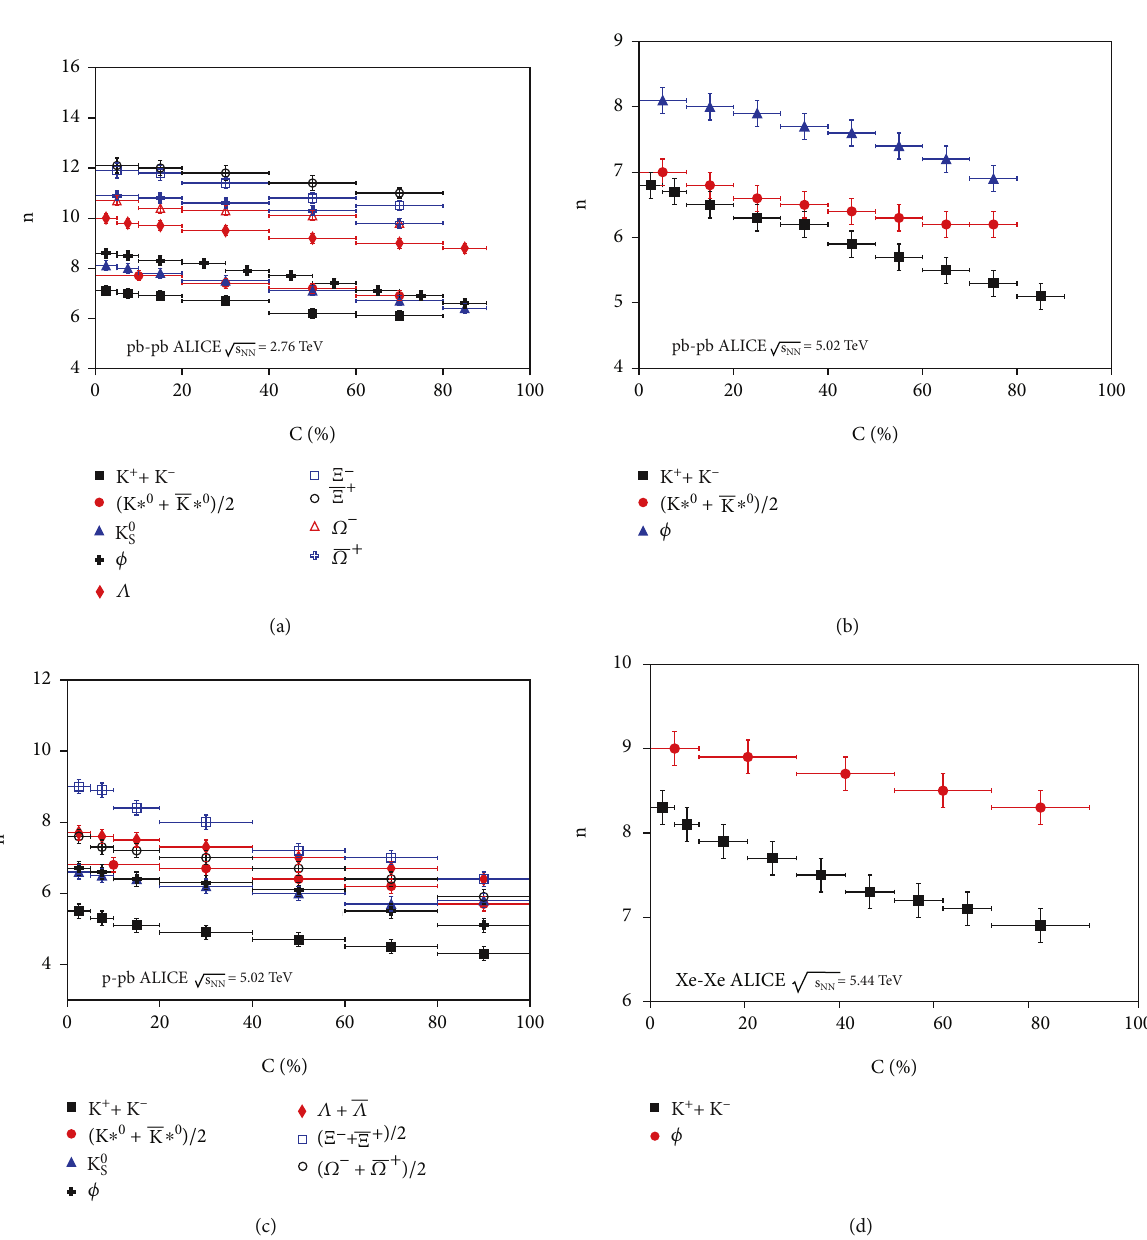
Figure 5: Dependence of entropy-related index (a, b) n on centrality and C in Pb – Pb, (c) p – Pb, and (d) Xe – Xe